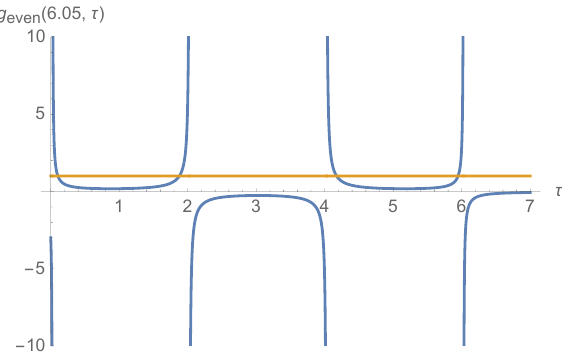
Figure 11. A plot g even ( (cid:28) ) for d = 6 : 05.